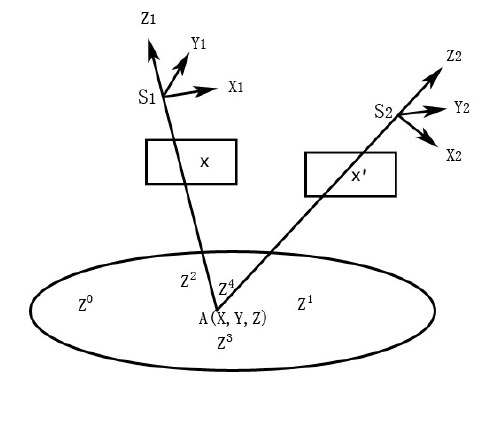
Figure.2 Illustration of elevation constraint As shown in Figure. 2, the object point A (X, Y, Z) is corresponded to the corresponding point x x  . If the LiDAR point is co-registrated accurately with the digital images, the elevation of point A will be equal to the interpolated elevation Zinter by the surrounding points: